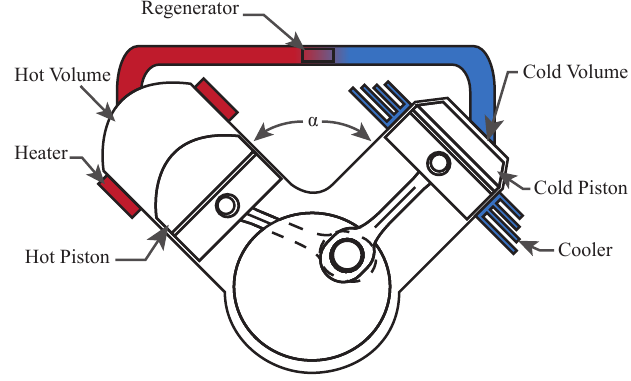
Figure 1. Schematic of an alpha-type Stirling engine. Table 1. Details of the engine used in the